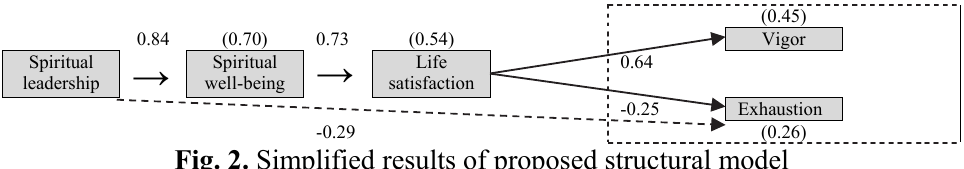
Fig. 2. Simplified results of proposed structural